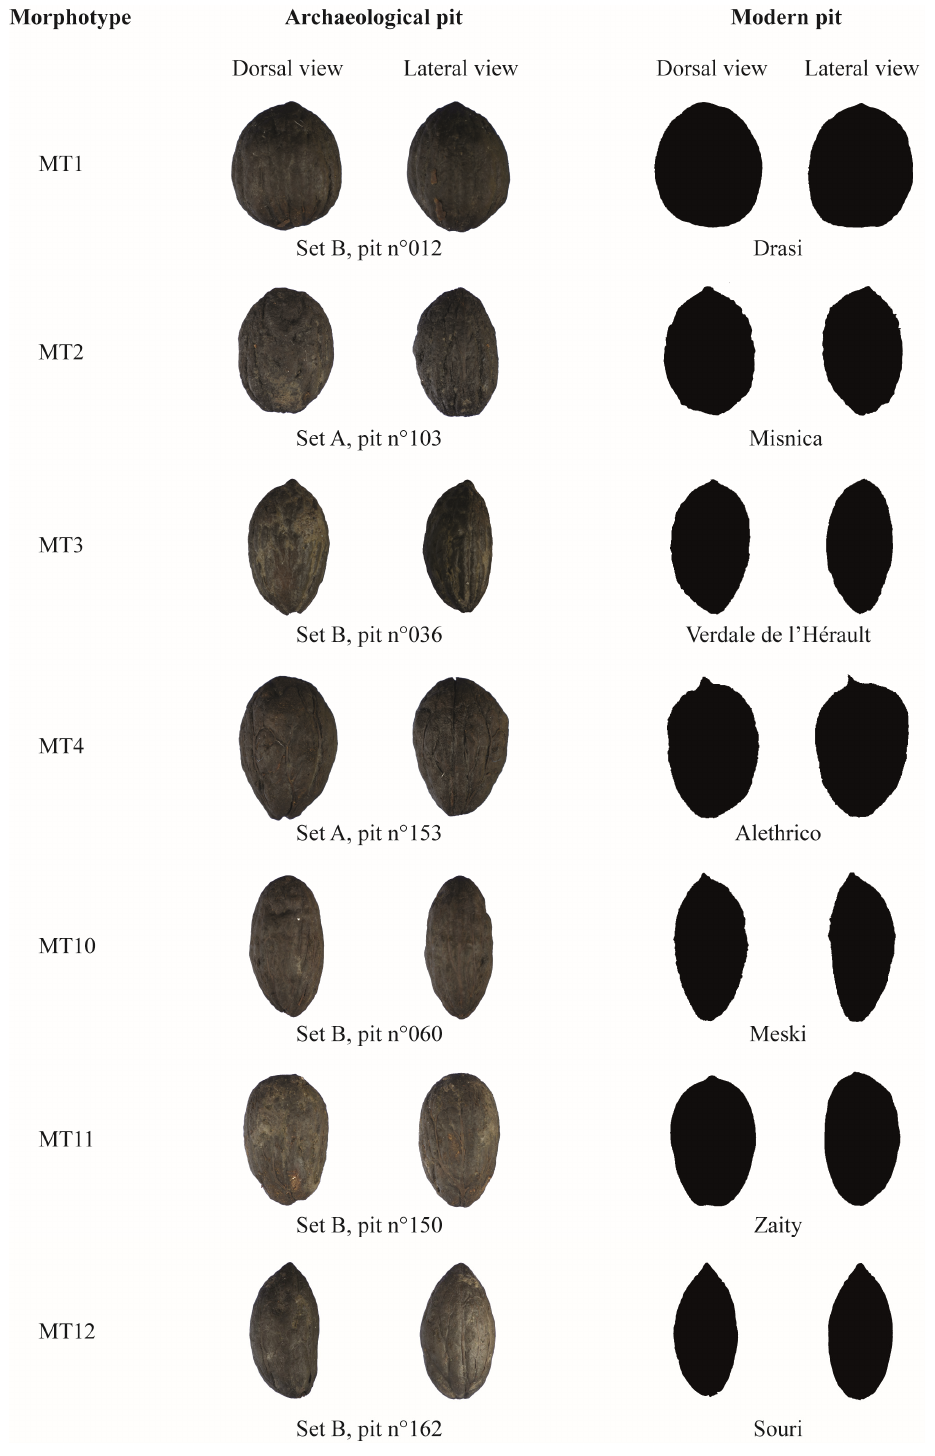
Figure 7. Photographs of archaeological stones from the Hishuley Carmel site allocated to modern olive morphotypes from which a representative was photographed and trimmed and the stone was masked before the extraction of open outline coordinates (photos taken by Sarah Ivorra and Clémence Pagnoux).